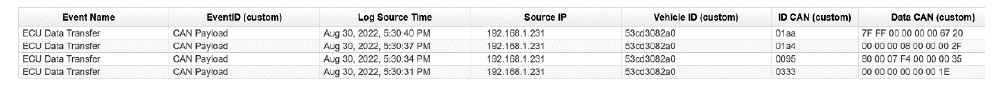
Figure 7. Result after creating all properties. On console it can be seen the correctly formatted payload.